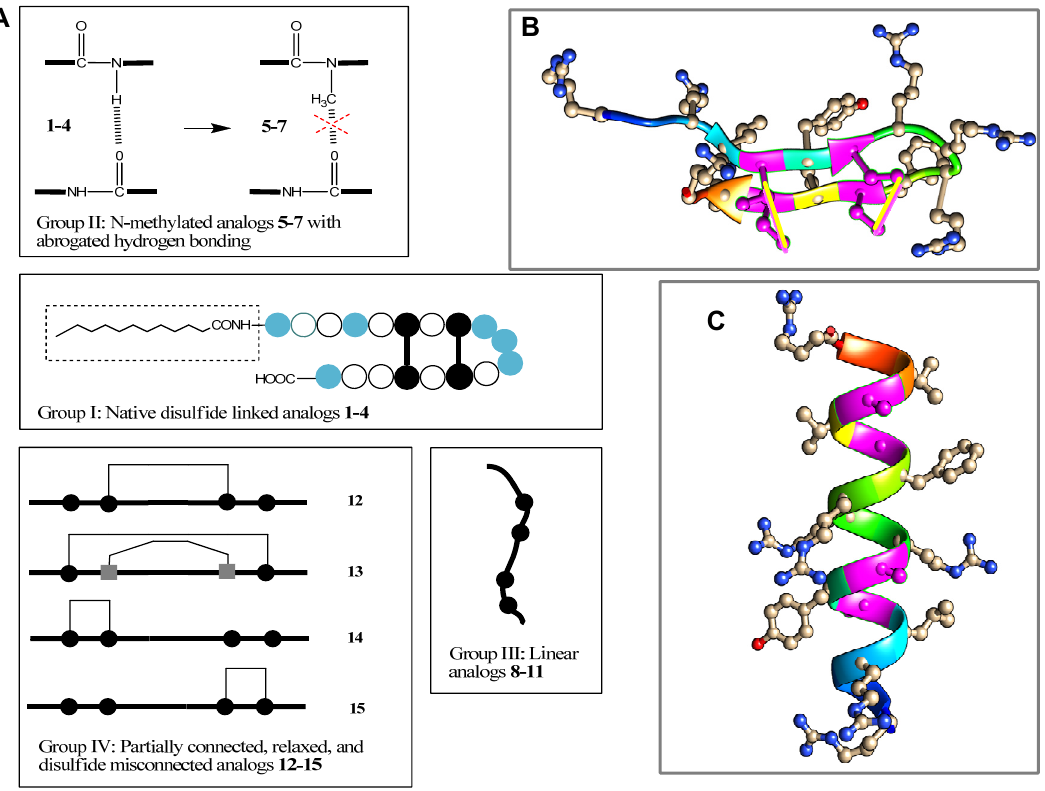
Figure 1. PG-1 and its analogs used in this study. ( A ) Schematic overview of analogs. [ = arginine or homoarginine ( 4 ); = cysteine or homocysteine ( 13 ); absence of H-bonding in 5 – 7 is indicated ( )]; the dotted box indicates the acyl chain in analog 3 . Three-dimensional structure model of PG-1 ( B ) and of its linearized non-cysteine containing analog 8 ( C ) with alanine replacements. The 3D structure of the PG-1 β -hairpin fold is predicted by I-TASSER based on the published crystal structures (PDB # 1PG1 and 1ZY6) and visualized using Chimera software. Cysteine residues that form disulfide bridges are magenta-colored. The 3D structure of a linearized analog 8 adopting a coil fold is achieved when four alanine residues are replaced by cysteines. The coil fold is predicted by I-TASSER and visualized by Chimera. Alanine residues are